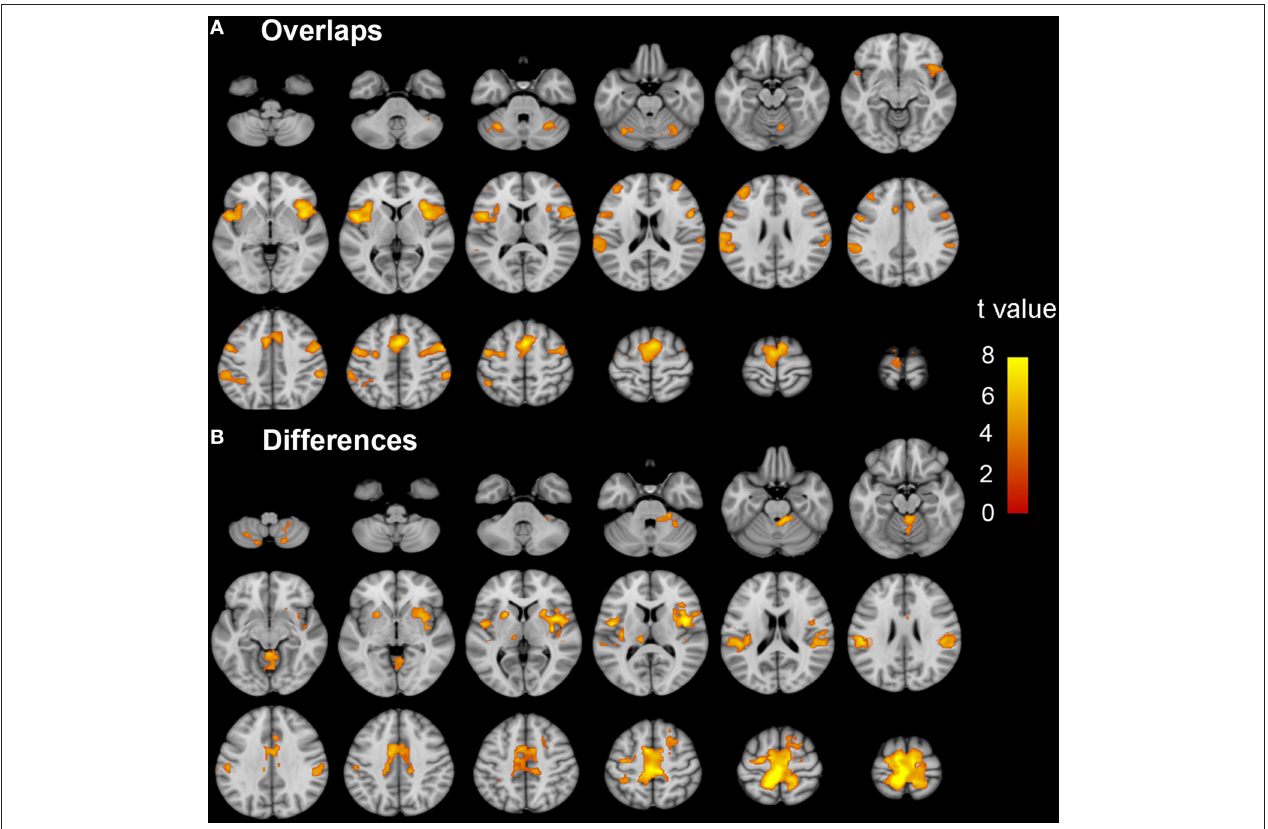
FIGURE 2 | The coactivation and differences between the MI and ME tasks in the NC group. Conjunction analyses between the MI and ME tasks shows coactivation in the bilateral SMA, dorsal premotor cortex, ventral premotor cortex, IPL, CB vermal 6, lobules 6, and Crus 1, aINS, dlPFC, and SMG (A) . Compared to the ME task, the MI task evoked weaker activation in the bilateral paracentral lobule, SMA, Putamen, SMG, CB lobule 8, right aINS, CB vermal and lobules 4–6, SFG and left thalamus (B) . Significant activation was considered at a voxel-wise threshold of q < 0.01 (FDR correction) and a cluster ≥ 30 voxels. The right side of the image corresponds to the right hemisphere. The color bar represents the t -values. MI, motor imagery; ME, motor execution; NC, normal controls; SMA, supplementary motor area; IPL, inferior parietal lobule; CB, cerebellum; aINS, anterior insula; dlPFC, dorsolateral prefrontal cortex; SMG, supra marginal